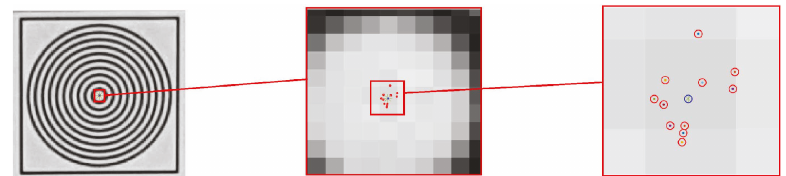
Figure 6: An example of the K -means clustering (KMC) result; the dotted points on the right are the centers of the ellipses, and the starred ones (blue) are the KMC result.